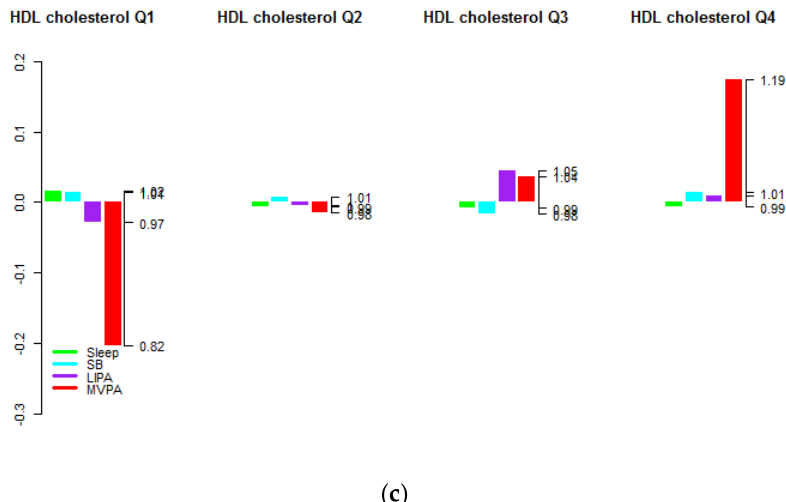
Figure 1. Average time-use compositions of the 24-h day by health indicator quartiles for adults aged (18–64) for ( a ) BMI, ( b )Aerobic fitness and ( c ) HDL cholesterol level (in log-ratio scale and relative to the overall average time-use composition at the zero baseline). The left axis gives the log-ratio value and the right axis gives the actual proportion relative to the mean composition (e.g., 1.19 means 1.19 times the compositional mean or a proportion higher by 19%).